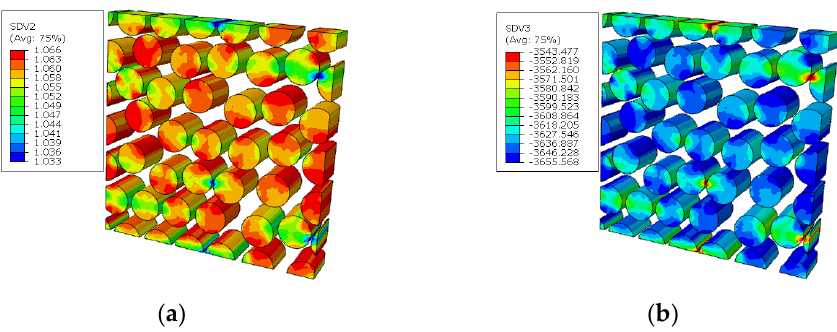
Figure 35. Matrix damage propagation in the matrix of fiber random distribution model. ( a ) at displacement loading 0.4 mm; ( b ) at displacement loading 0.54 mm. displacement loading 0.4 mm; ( b ) at displacement loading 0.54 mm.